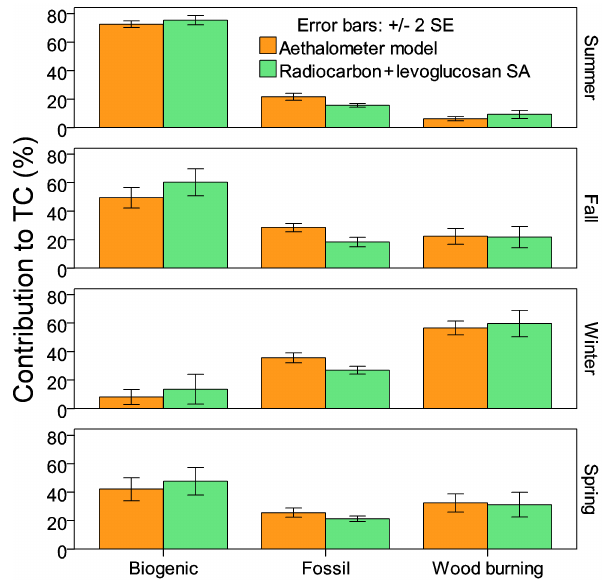
Figure 6. Seasonal comparison of source contribution to to- tal carbon (TC) between the Aethalometer model and radiocar- bon + levoglucosan source apportionment (SA). Error bars display 2 times standard error of the mean